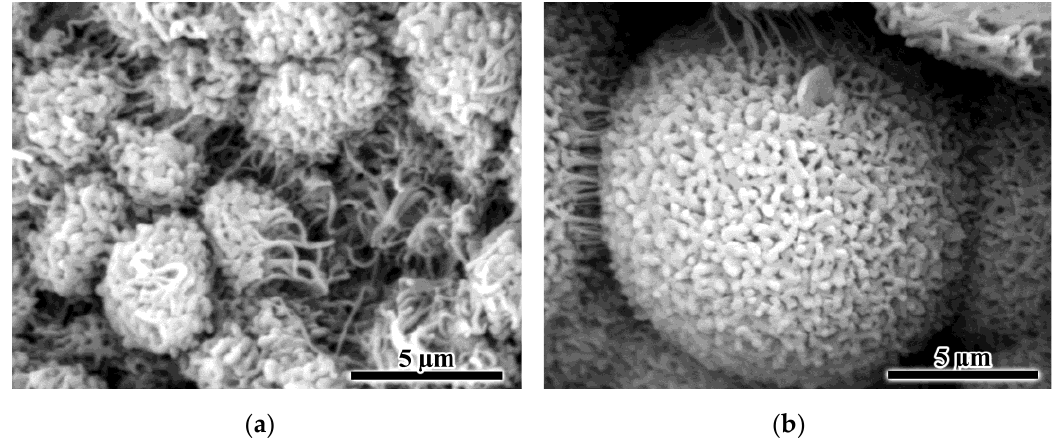
Figure 8. SEM images of aggregates obtained from 25% ( a ) and 40% ( b ) polylaurolactam solutions by cooling.